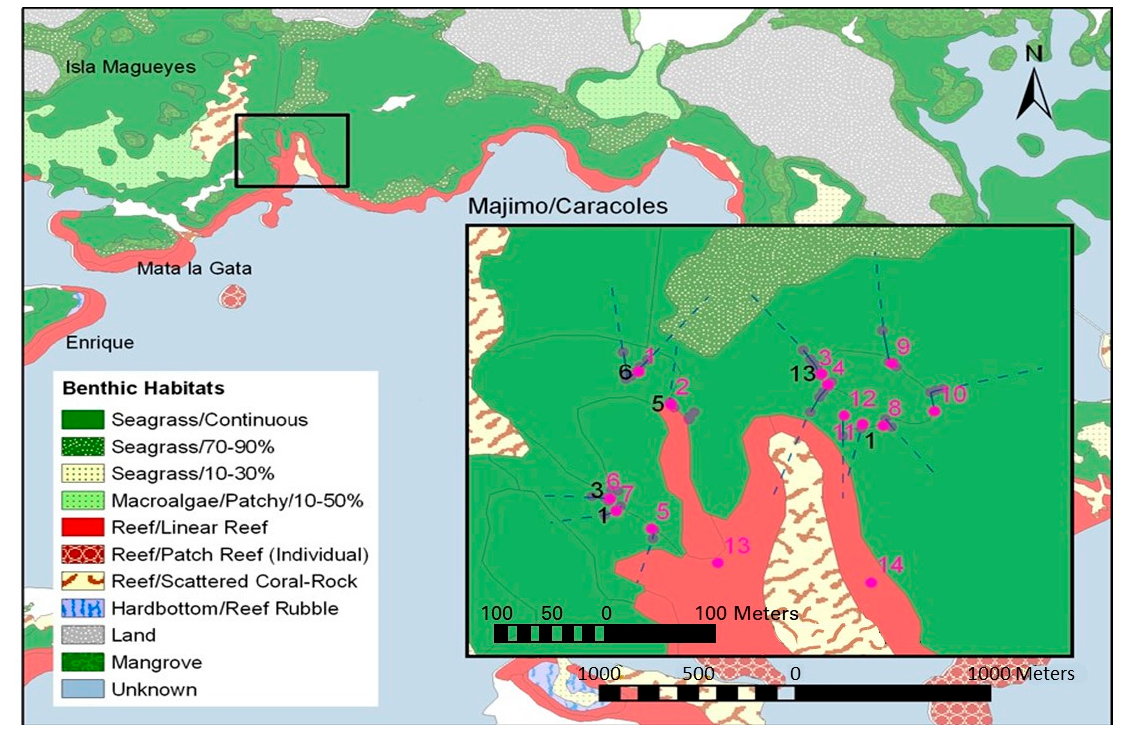
Figure 3. Location of juvenile grunt resting schools monitored for tags at Majimo/Caracoles reef in La Parguera, Puerto Rico. Red numbers and dots are the schools (See Table 1); black numbers are the number of recaptured individuals at each location from a total of 168 tagged at Site 1. Solid blue lines are the confirmed feeding routes, while dashed lines are the extension of those routes. Benthic habitats shown are from Kendall et al. [37]. Table 1. Descriptive statistics for fork length (cm) by location of all juvenile Haemulon spp. observed in resting schools found in the Majimo/Caracoles area of the initial mark-recapture study. Samples are the number of sampling events. N is the number of fish caught and measured.